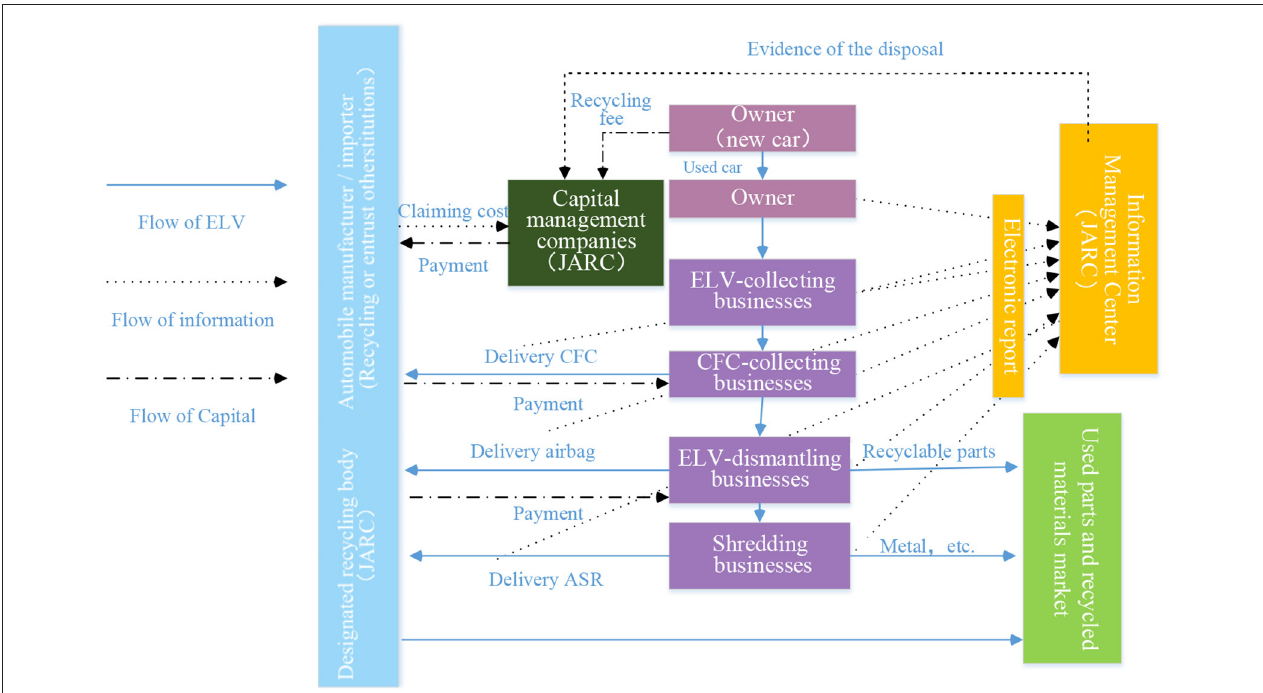
FIGURE 9 | Japan’s ELV recycling management framework 0.